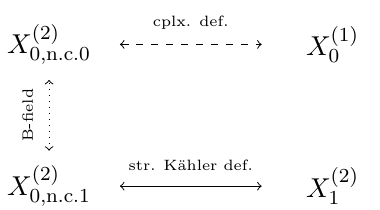
with two sections, the 1 and the generic elliptic fibration X (1) 0 0